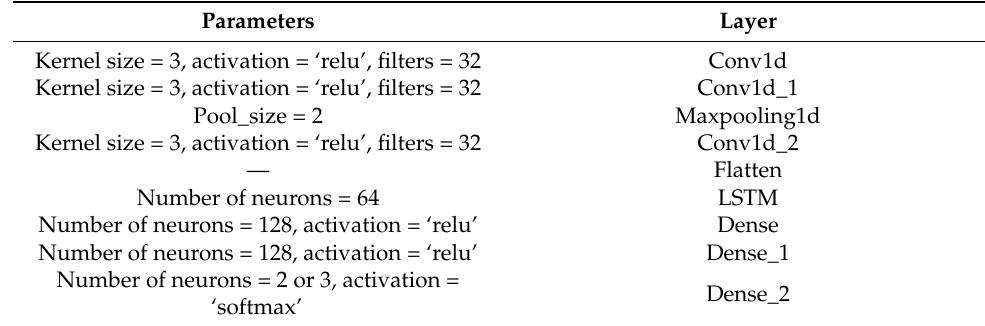
Figure 6. Block diagram of the proposed CNN–RNN network. Table 5. CNN–RNN